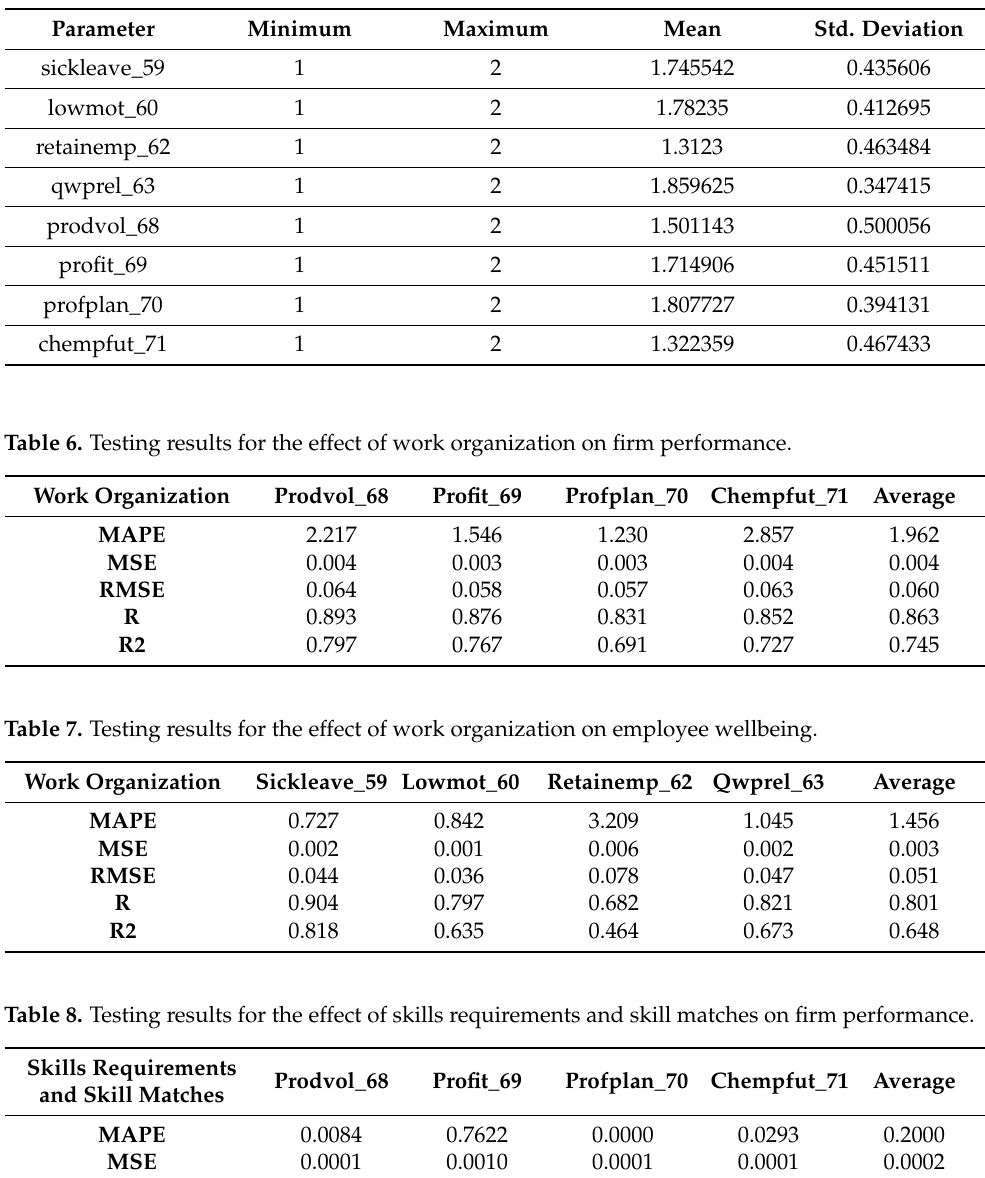
Table 5. Descriptive statistics for the effect of results on the dataset.